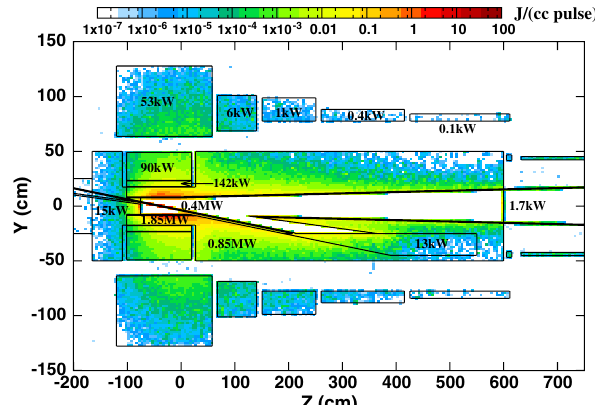
FIG. 3. Distribution of the deposited energy density (J/cc) per beam pulse (50 Hz repetition rate) in the Study 2 target system. Also shown is the estimated deposited power within various